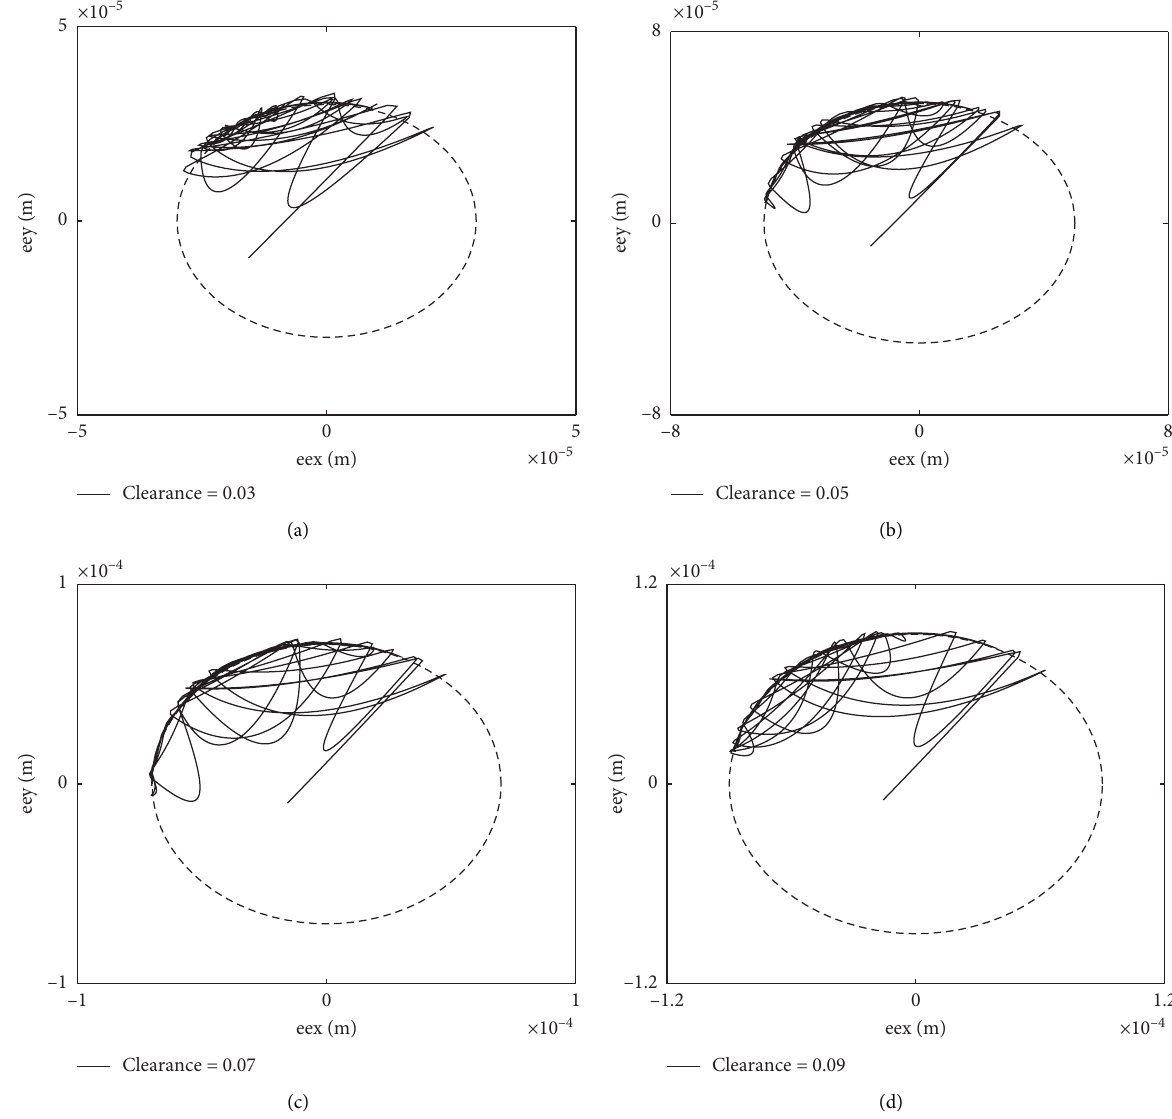
Figure 18: Shaft center motion trajectory. (a) Clearance � 0.03mm. (b) Clearance � 0.05mm. (c) Clearance � 0.07mm. (d) Clearance �